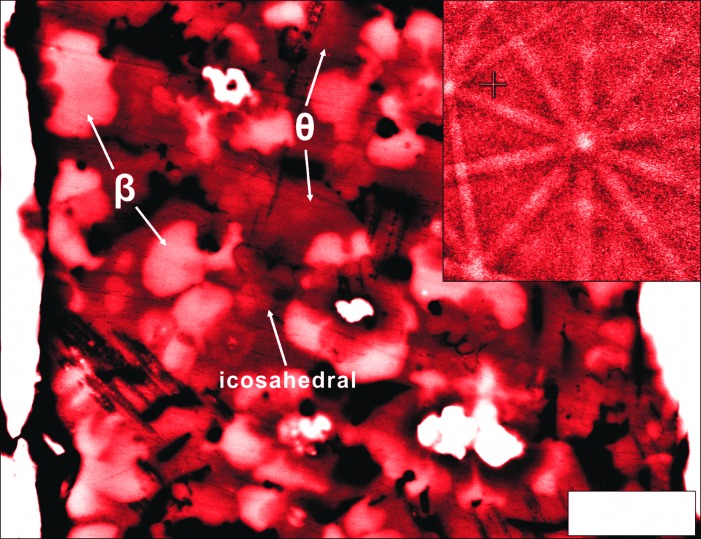
The Al62Cu31Fe7 icosahedral quasicrystal revealing fivefold rotation and its coexisting Cu–Al phase assemblage of stolperite (β, AlCu) + khatyrkite (θ, Al2Cu) from a laboratory-shocked sample. Adapted from Hu et al. (2020 ▸).